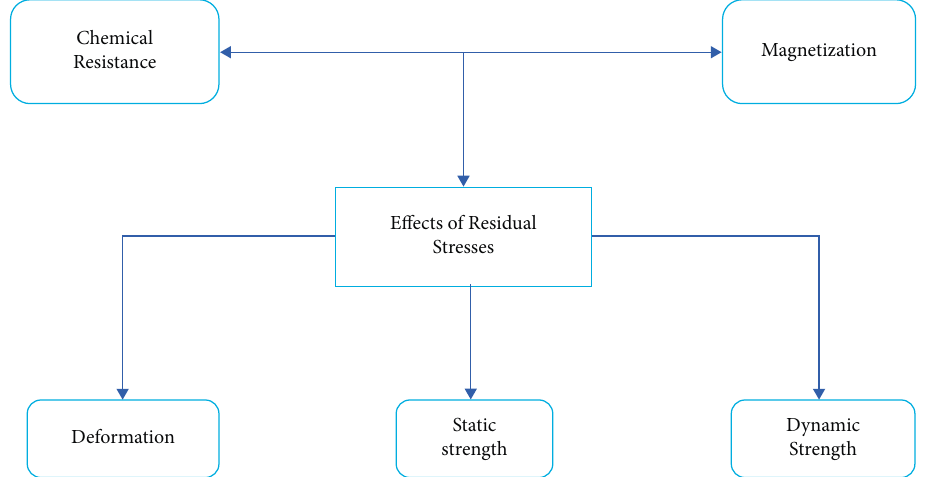
Figure 1: Residual stress effects in materials (adapted from ref.